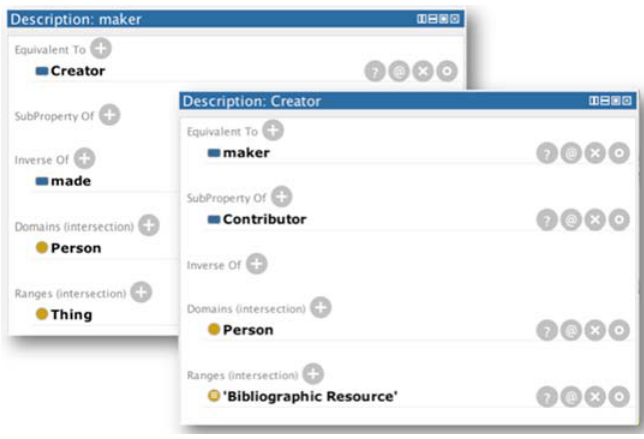
Figure 6. Equivalency of the “Creator” and “Maker” properties .